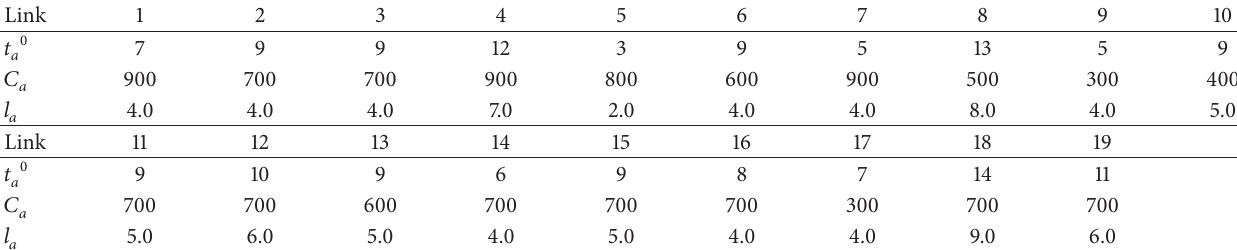
Table 2: Link related parameters of the example network (min, veh/hr, km).